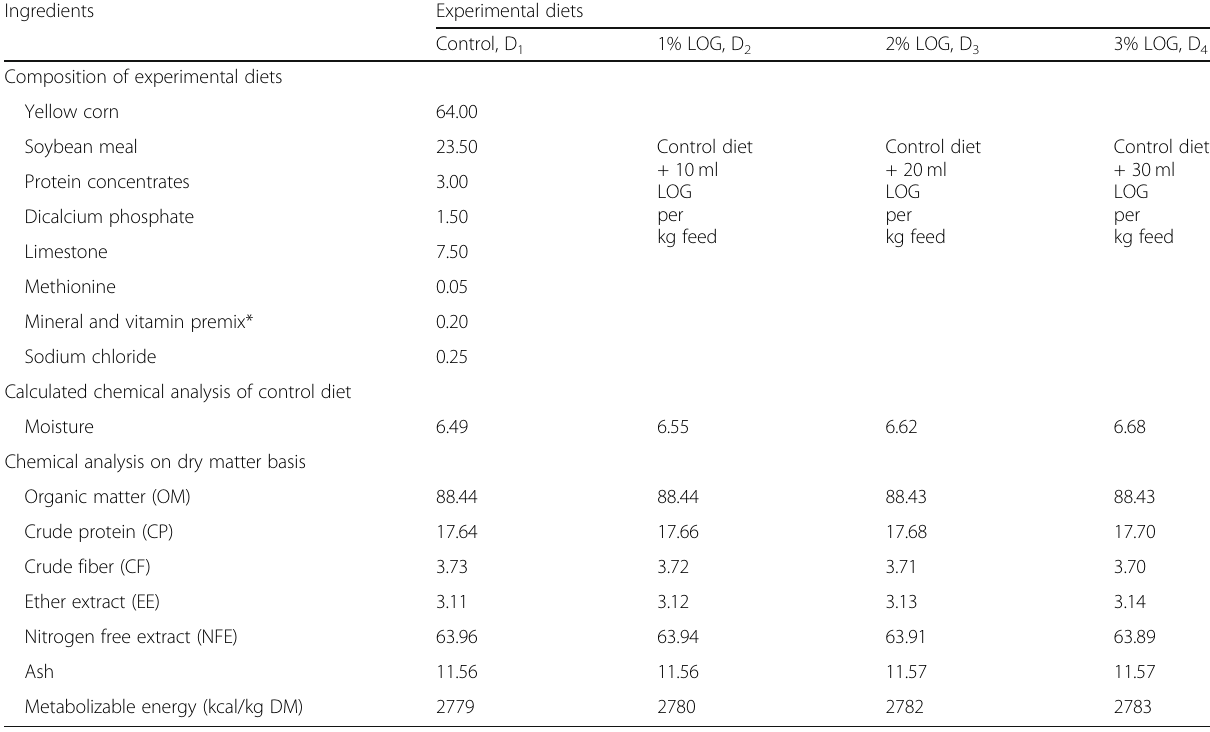
Table 2 Composition and calculated chemical analysis of the experimental diets